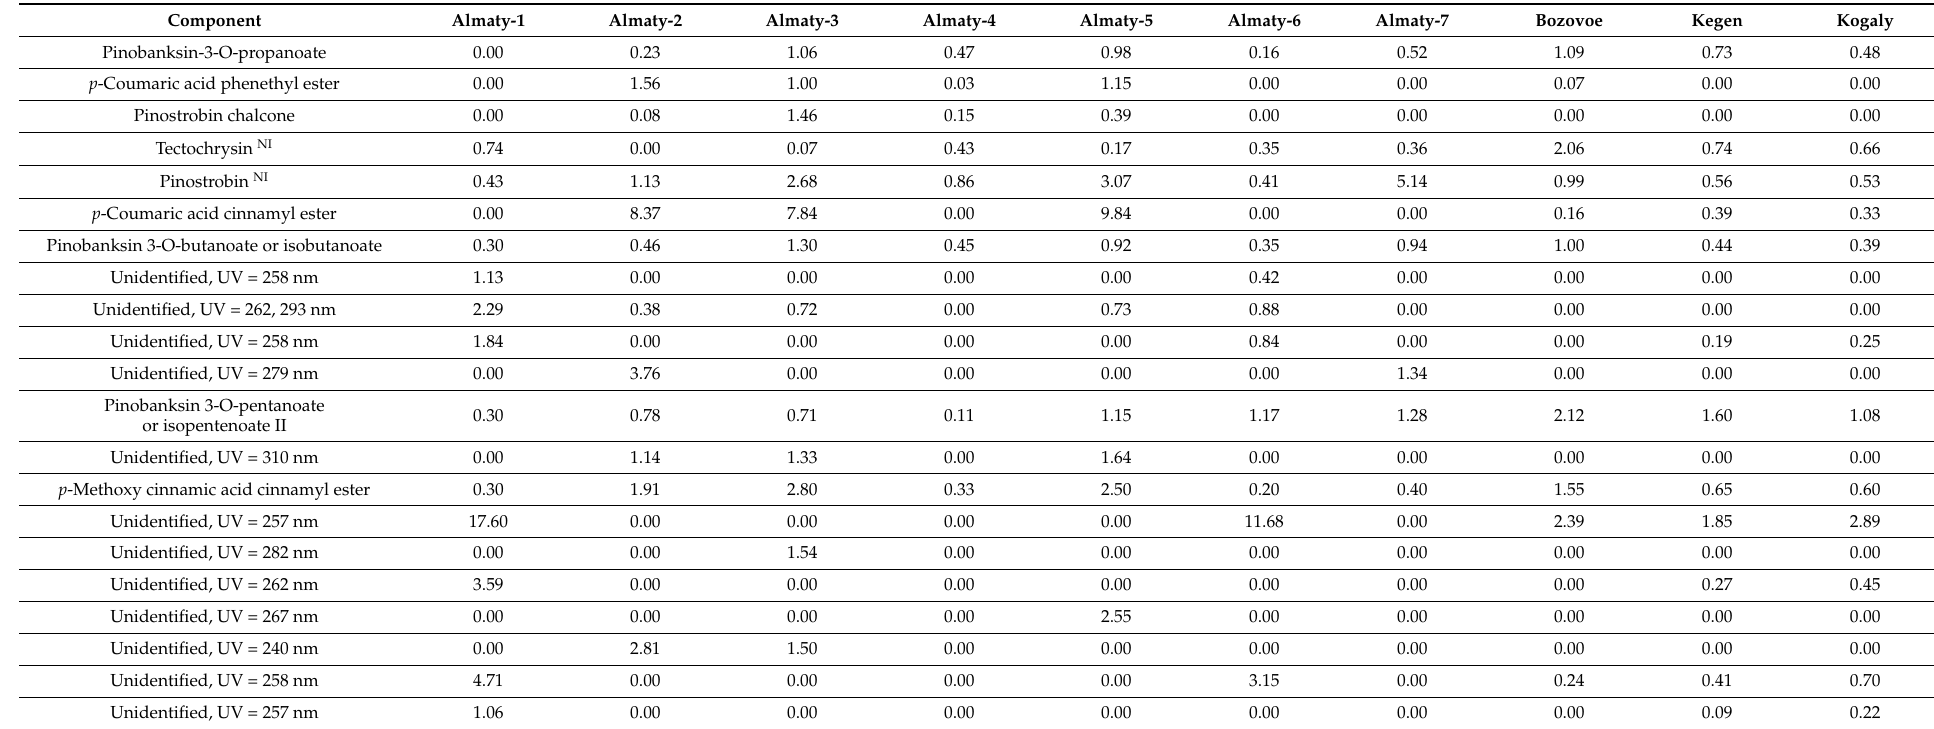
Table legend: * component presence was described as % of UV chromatograms (280 nm) relatively peak area; NI —component did not produce ions in negative mode in experimental conditions (it was not presented in Tables 1 and